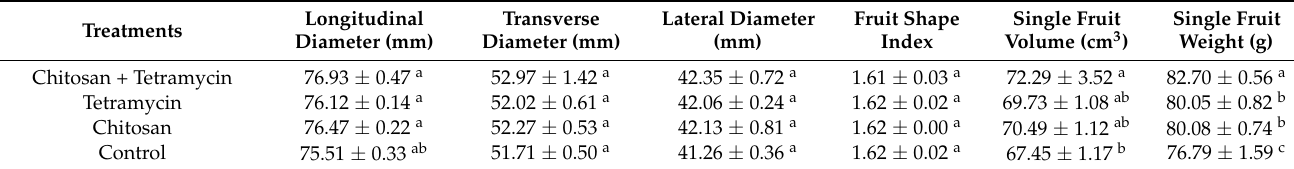
Values indicate the mean ± SD of three replicates. Small letters indicate significant differences at 5% level ( p <